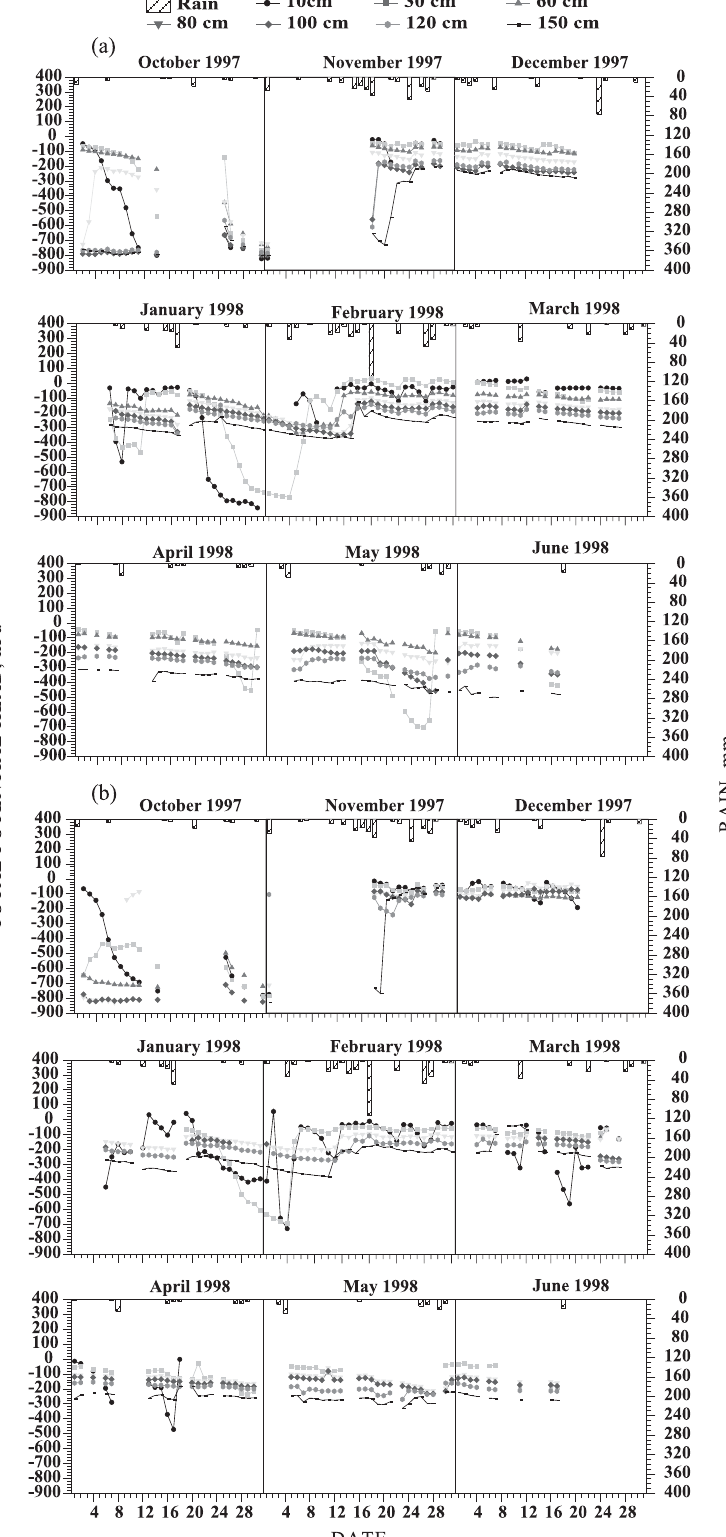
Figure 8. Daily variations of the total water potential head in tensiometric station 3 (TS3) situated in upper shoulder segment (a), and in tensiometric station 4 (TS4) situated in lower shoulder segment (b). Blank spaces in the graphs correspond to periods where no measurements could be made or to problems with the functioning of the